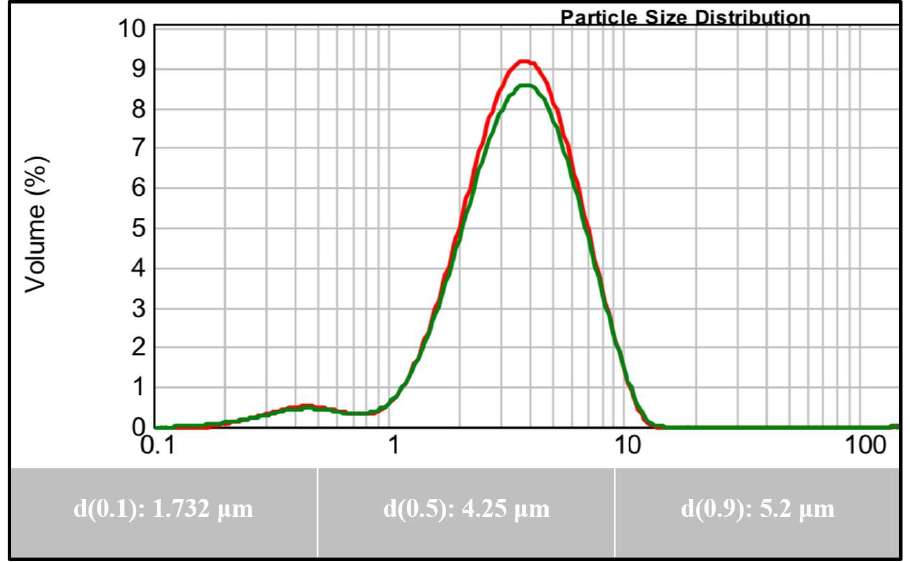
Figure 1. Particle Size Analysis of Lornoxicam .